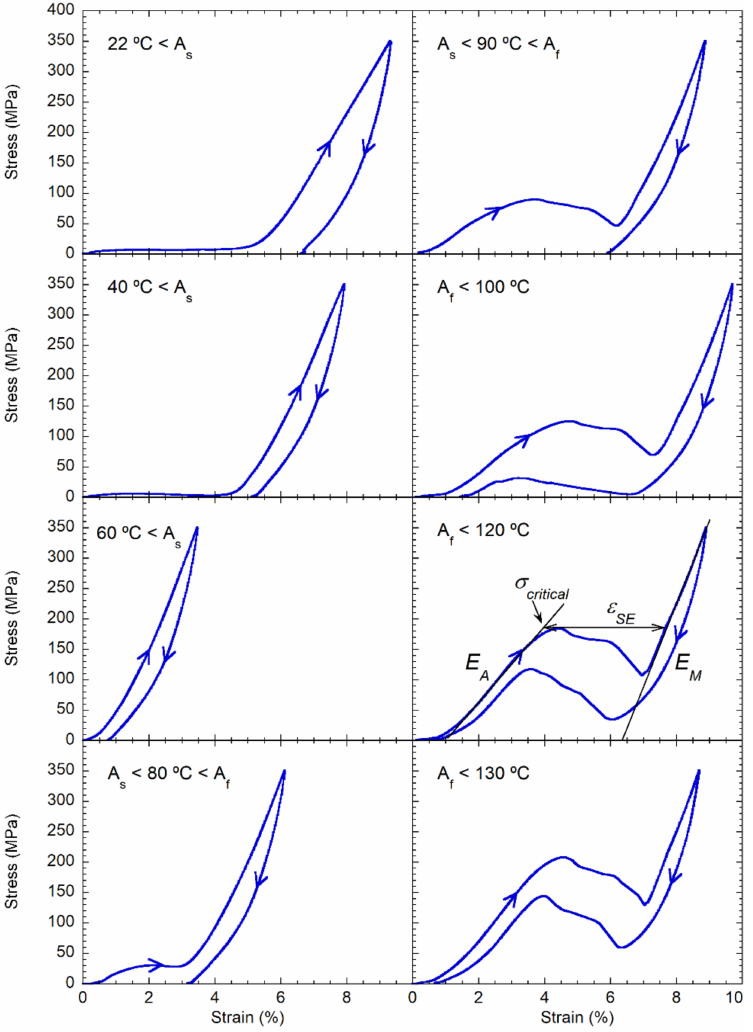
Figure 1. Stress–strain compression curves at different temperatures: below A s = 69 ◦ C, in the interval A f -A s , where A f = 92 ◦ C, and above A f of the thermally induced reverse MT. The schematic at temperature 120 ◦ C shows how the values of critical stress ( σ critical ), superelastic strain ( ε SE ), and Young’s moduli of the austenitic ( E A ) and martensitic ( E M ) phases were